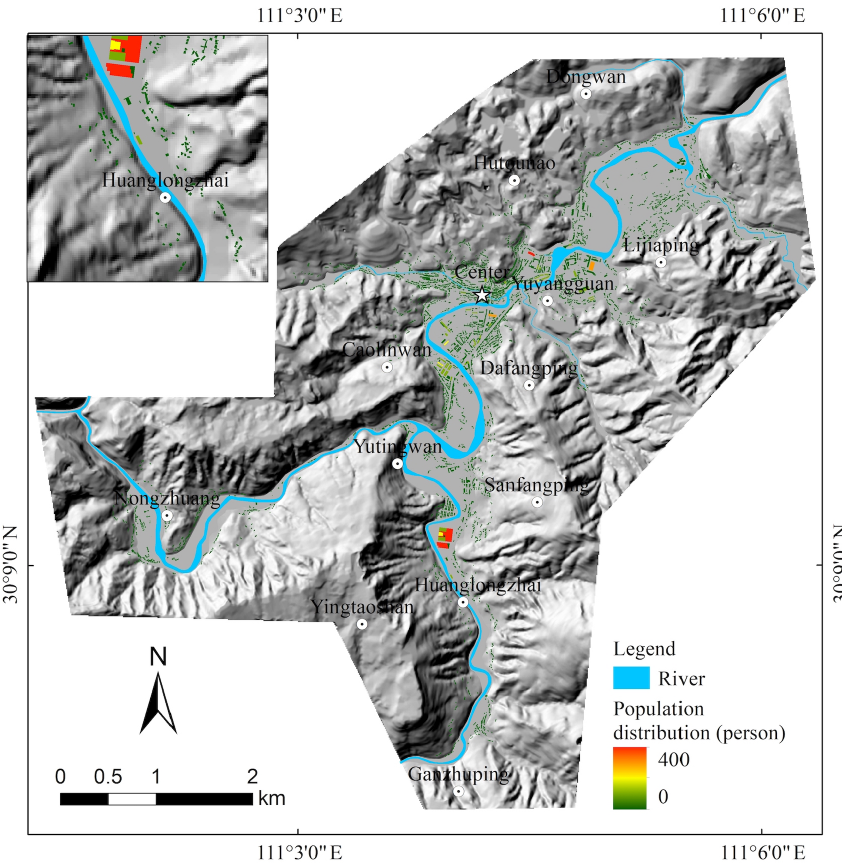
Figure 6. Population distribution map of the Yuyangguan community.